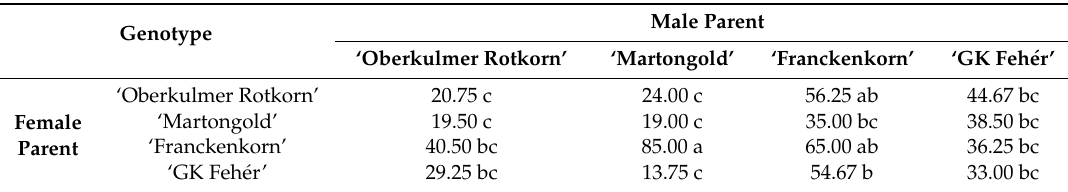
Table 2. Mean of green plantlets in anther culture of a full diallel spelt wheat population. Values with the same capital letters are not significantly di ff erent ( p > 0.05).